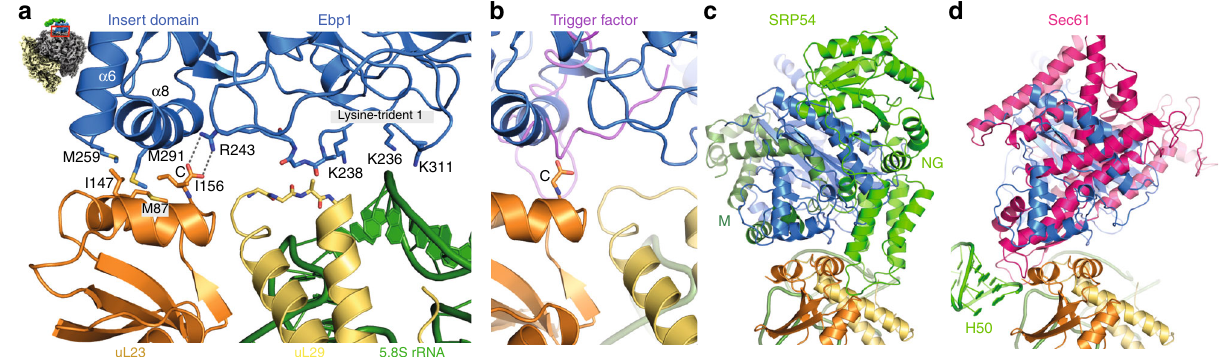
Fig. 3 Ebp1 binding to the inner ring of the tunnel exit. a The insert domain of Ebp1 (blue) binds to the general docking site, including ribosomal proteins uL23 (yellow) and uL29 (orange). Three lysine residues within the MetAP-core fold triangulate 5.8S rRNA helix H24 (green). View is rotated in plane by 180° in respect to Fig. 1c bottom and as indicated by the small representation in the corner. b Bacterial Trigger factor 30 (PDB ID: 1W2B) exploits the same binding mode to uL23. c The SRP GTPase SRP54 is incompatible with Ebp1/MetAP binding. The NG domain binds to uL29 32, 34 (PDB ID: 3JAJ) and does not interfer with the insert domain, while signal-recognizing SRP54M (dark green) competes for uL23 binding (view rotated vertically by 90° to panel ( a )). d The Sec61 translocon displaces SRP54 and reaches deep into the tunnel exit up to 28S rRNA H50 35, 36 (PDB ID: